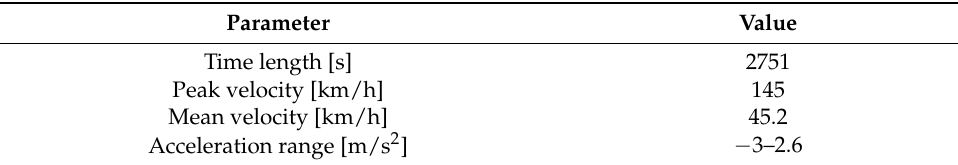
Table 2. Main properties of the Random